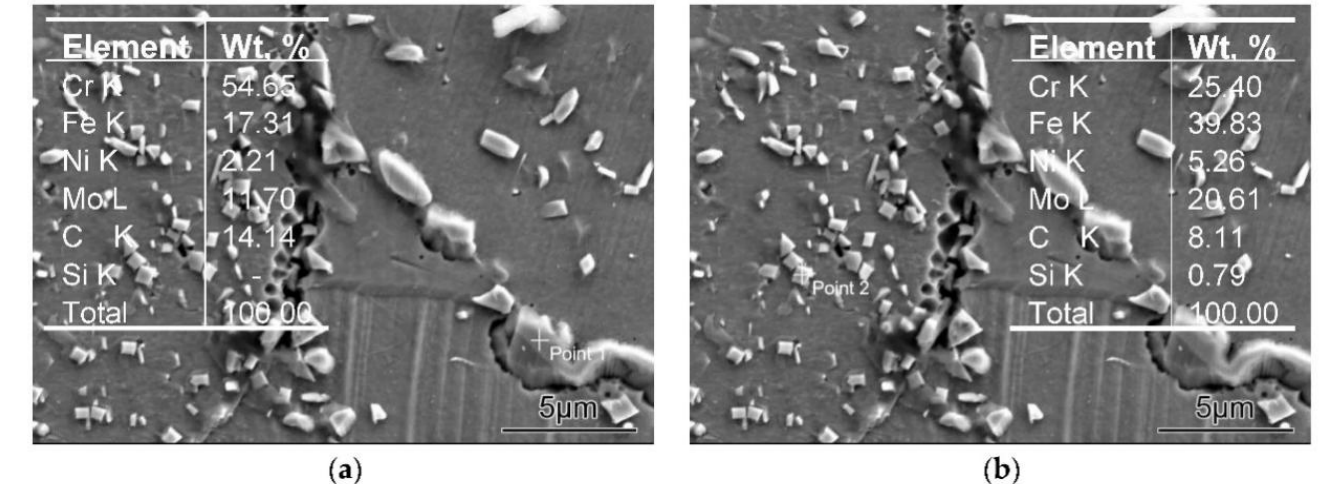
Figure 3. EDS analysis of the precipitates from the 300 h aged specimens: ( a ) intergranular precipitates, ( b ) intragranular precipitates.